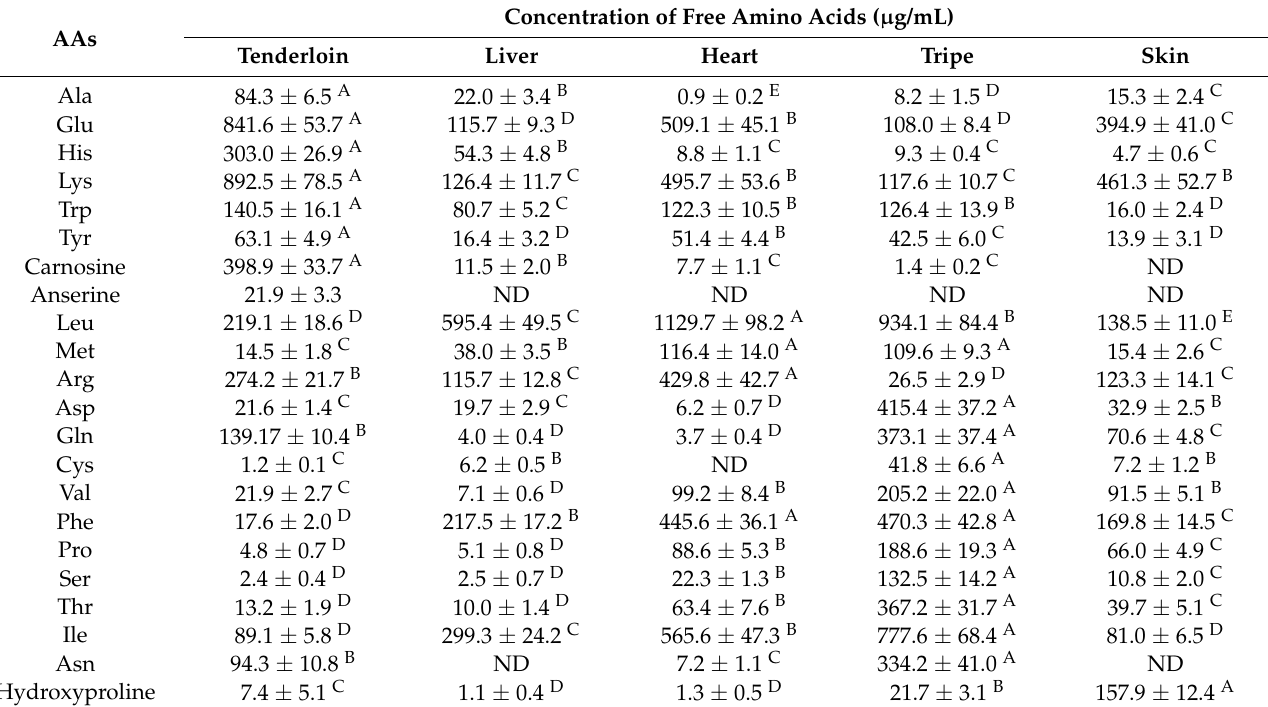
Table 2. Comparison of liberated free amino acids of tenderloin and edible pork by-products after the gastrointestinal digestion.